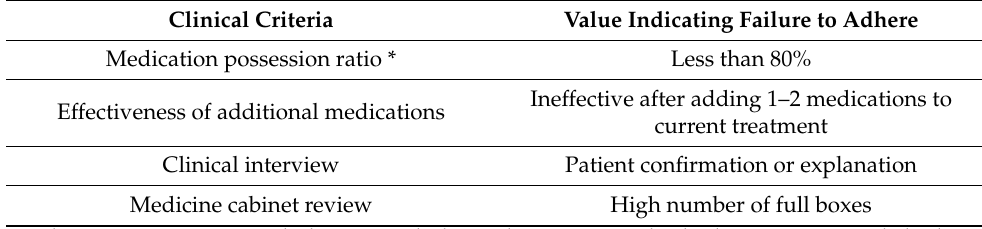
Table 1. Clinical criteria and corresponding value indicating failure to